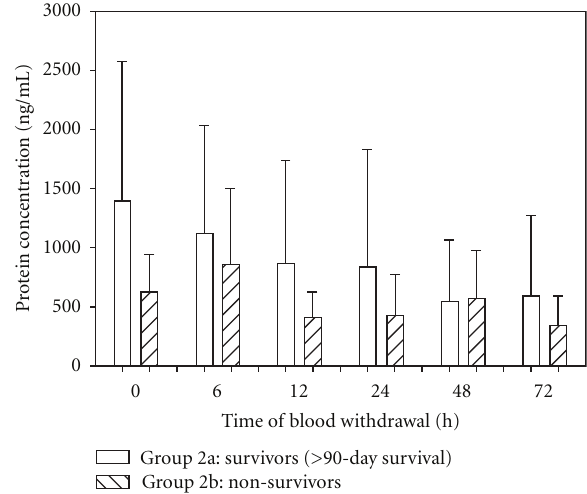
Figure 6: Mean MMP-9 serum levels were remarkably lower in non-survivors (group 2b) than those in survivors, especially within the 24 h after the traumatic event. Data were analyzed by Mann- Whitney Rank Sum test and presented by mean ± standard error of the mean.